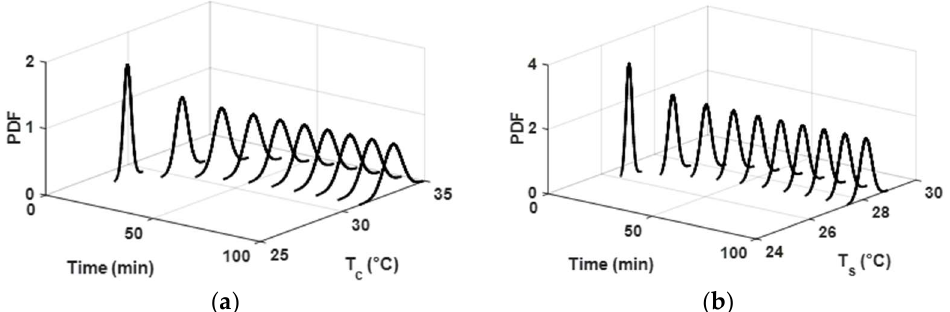
Figure 10. Distribution of temperatures for a few time intervals estimated with the generalized polynomial chaos (gPC) coefficients and the correction gains, which can be used to define a two-dimensional domain to generate JCR profiles for FDD: ( a ) Core temperature approximated with gPC and correction gains and ( b ) surface temperature approximated with gPC and correction gains.